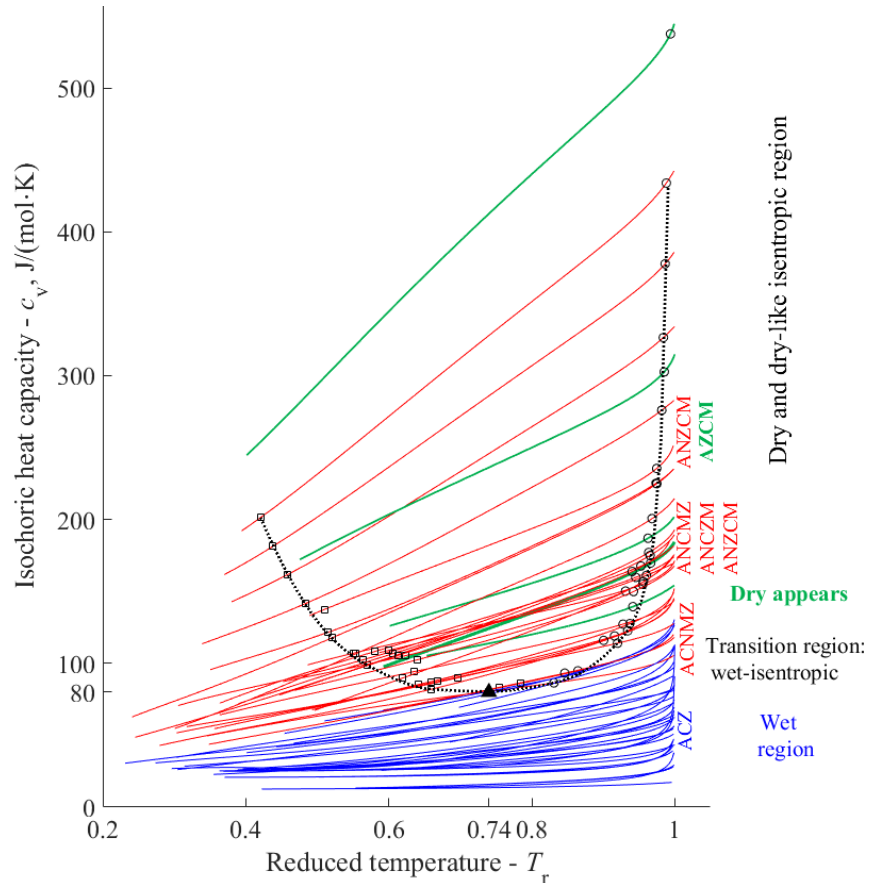
Figure 4. Molar isochoric specific heat capacity (kJ/mol · K) curves of various working fluids in saturated vapor conditions; blue, red, and green curves represent wet, isentropic, and dry materials, respectively. Squares and circles represent points N (lower temperature) and M (higher temperature). The triangle shows the border between wet and non-wet fluids, located at T r = 0.74 and c V = 80 J/mol · K. The dotted curve represents the outer envelope for points M and N.